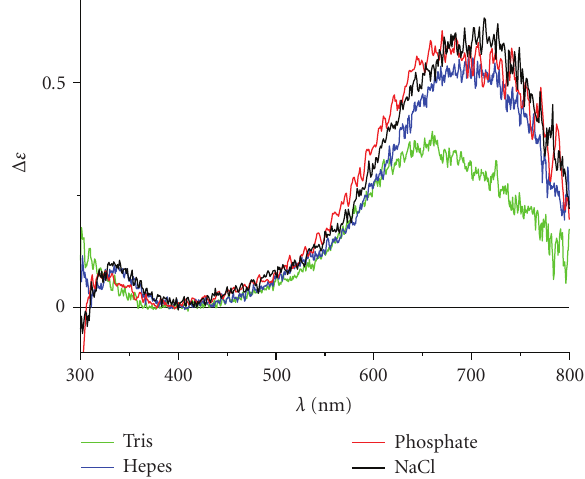
Figure 4: Spectra of pure forms of MBS-Cu(II) complexes obtained by extrapolation of titration data.